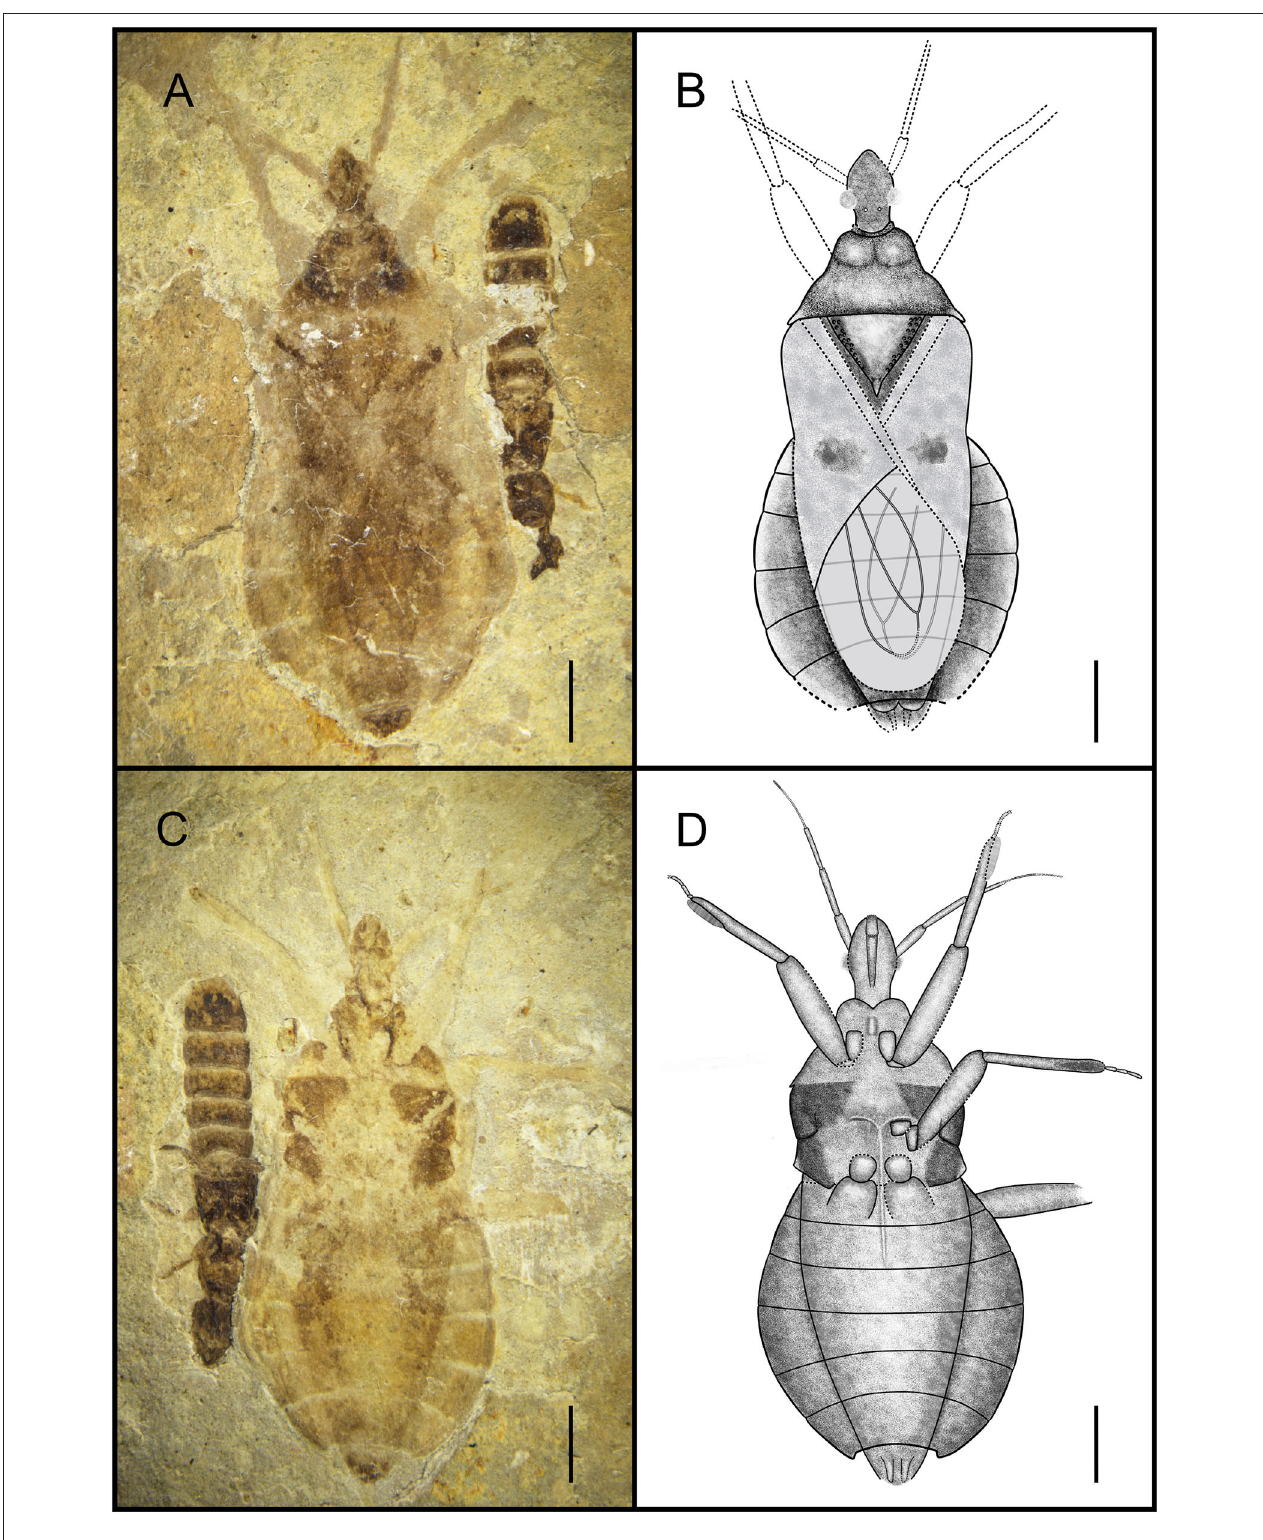
FIGURE 2 | Habitus of Simplicivenius rectidorsius gen. et sp. nov., holotype. CNU-HET-LB2022002 (A) Photograph in dorsal view. (B) Line drawing in dorsal view. (C) Photograph in ventral view. (D) Line drawing in ventral view. Scale bars = 2mm.